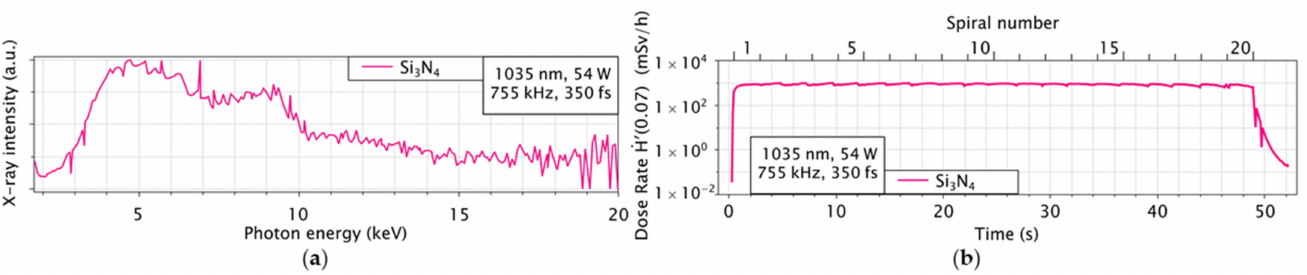
Figure 6. Shown in ( a ) is the spectrum of Si 3 N 4 measured with the Silix lambda and in ( b ) is the corresponding dose rate over time measured with the